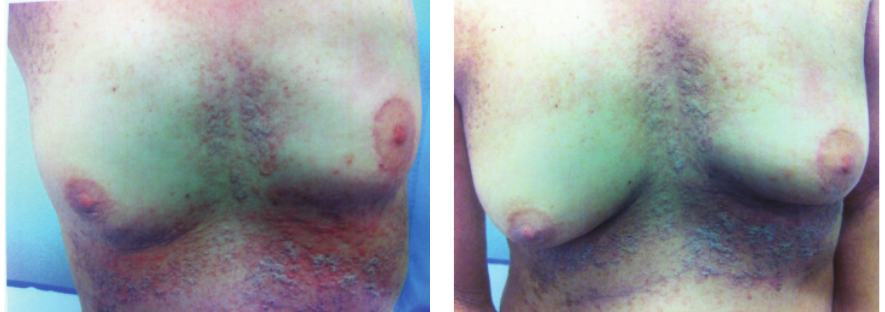
Figure 1: Skin features at diagnosis.